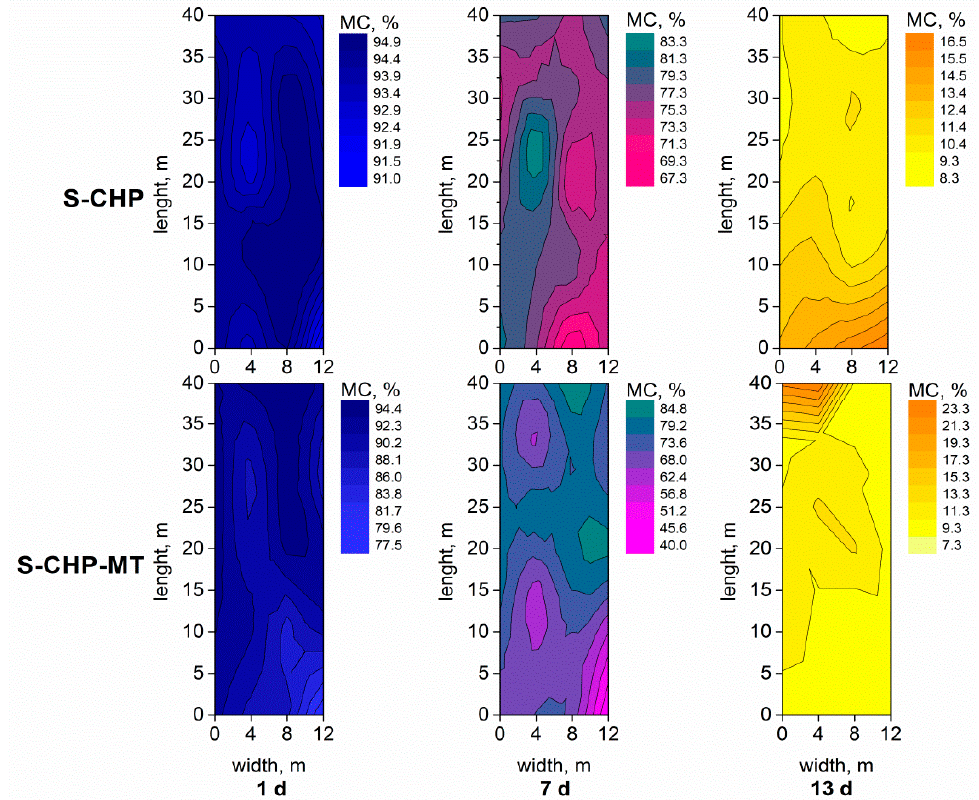
Figure 4. Spatial pattern of the moisture content (MC) of the digestate across the drying area based on the interpolation of 20 grid measurements after 1, 7 and 13 d of the drying with solar energy and waste-heat of a combined heat and power unit (S-CHP) and with additional use of the exhaust air of a micro turbine (S-CHP-MT).